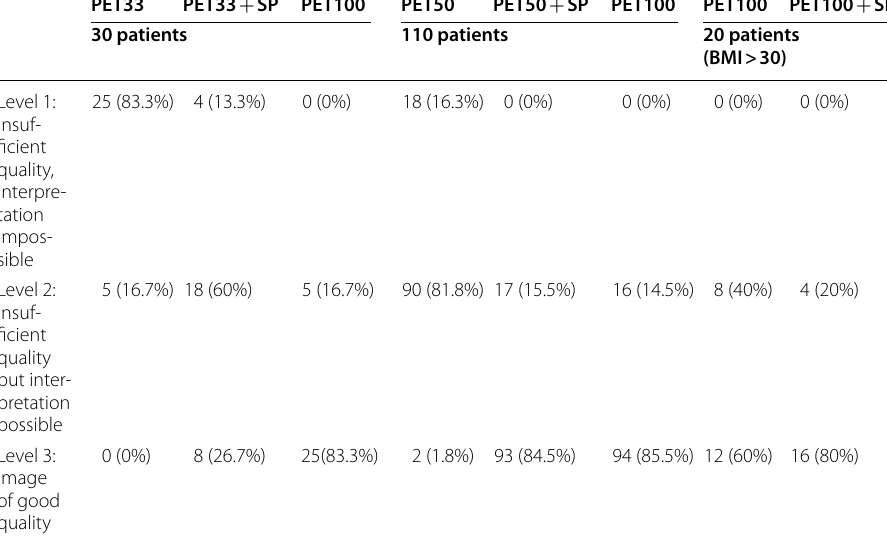
Table 6 Image quality quotation on a 3-point scale, for the PET 33, PET33 and PET100